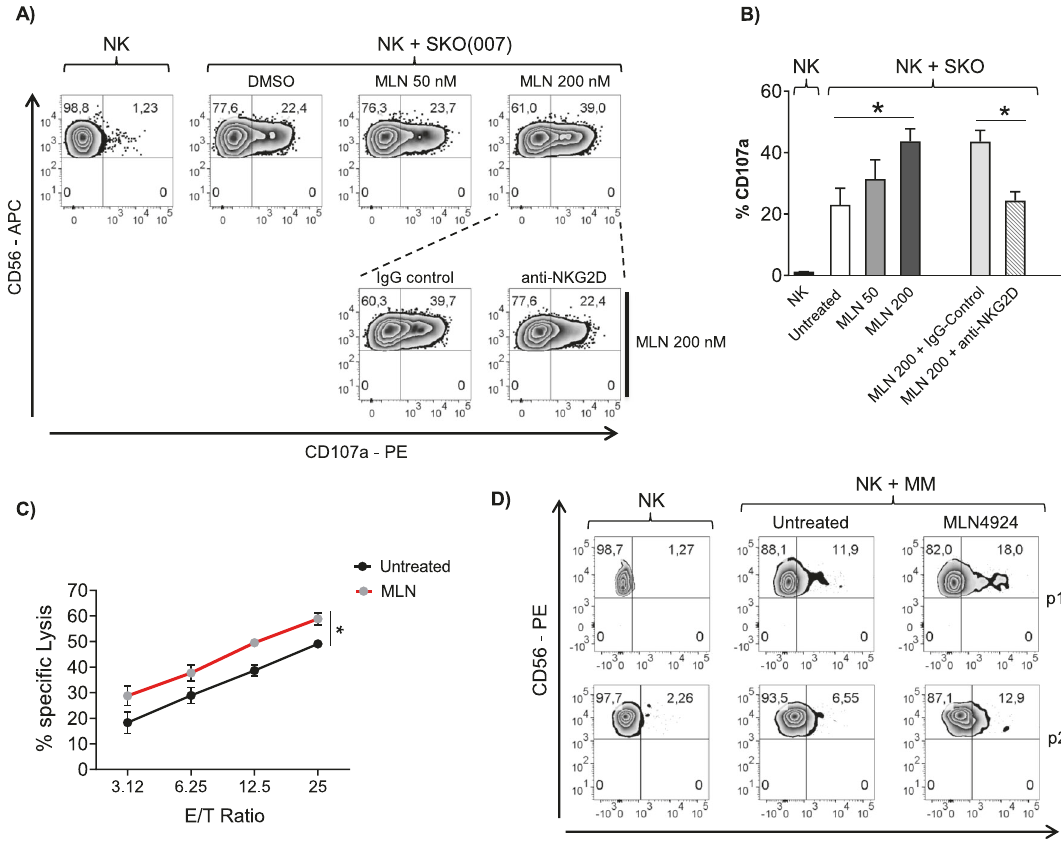
Fig. 4 Increased susceptibility of MLN4924-treated MM cells to NK cell recognition and degranulation. Primary cultured NK cells obtained from PBMCs isolated from healthy donors, were incubated with SKO-007(J3) cells, untreated or treated with the indicated concentration of MLN4924 for 72 h as described above and used as target cells in a degranulation assay. The assay was performed at the Effector:Target (E:T) ratio of 2.5:1. After 2 h at 37 °C, cells were stained with anti-CD56, anti-CD3 and anti-CD107a mAbs. Cell surface expression of CD107a was analyzed on FSC/SSC-gated and CD56 + CD3 − cells. To evaluate the role of NKG2D, cells stimulated with the highest dose of MLN4924, were incubated with NK cells pretreated with anti-NKG2D blocking antibody or IgG control. A Representative degranulation. B Percentage of CD107a positive cells was calculated based on four independent experiments and statistical signi fi cance was evaluated by paired Student t test (* P < 0.05). C Primary cultured NK cells from different donors were incubated with SKO-007(J3) cells untreated or treated with MLN4924 (200 nM) for 48 h and used as target cells in 7-AAD/CFSE cell-mediated cytotoxicity assays. These assays were performed in triplicate at the Effector:Target (E:T) ratios ranging from 3.125 to 25:1. D ) CD138- bone marrow cells, cultured for 2 days in complete medium supplemented with IL-2 (200 U/mL), were incubated with puri fi ed autologous myeloma cells, untreated or treated with MLN4924 as described above, and used as target cells in a degranulation assay. The assay was performed at the Effector:Target (E:T) ratio of 2.5:1. After 2 h at 37 °C, cell surface expression of CD107a was analyzed on CD56 + CD16 + CD3 − cells. Results obtained from two patients (P19 and P20) are